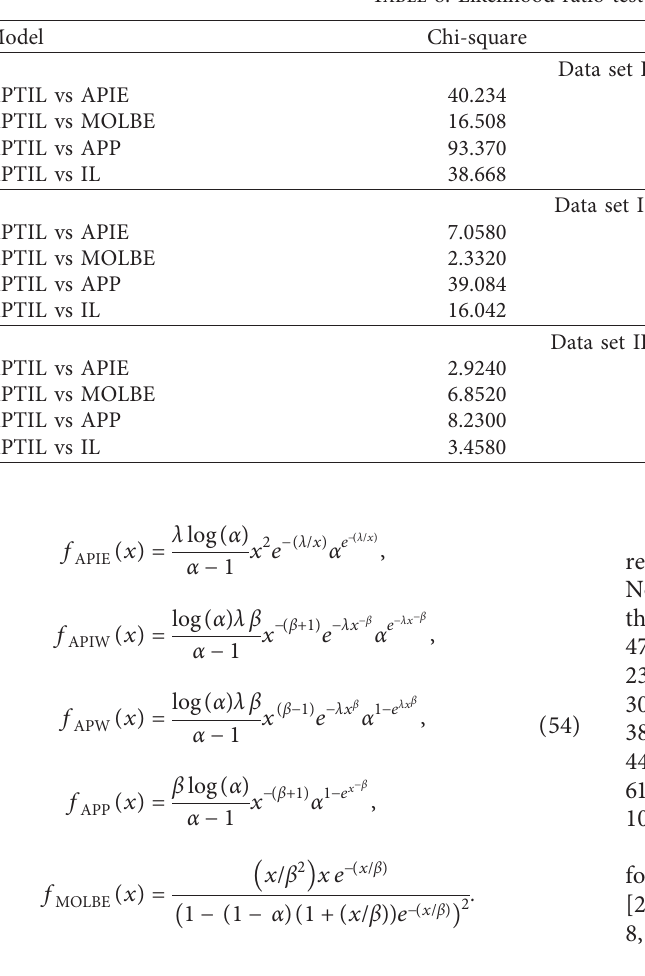
Figure 7: Estimated pdf and cdf of the APTIL model and other competing models for third Table 8: Likelihood ratio test results for data sets.